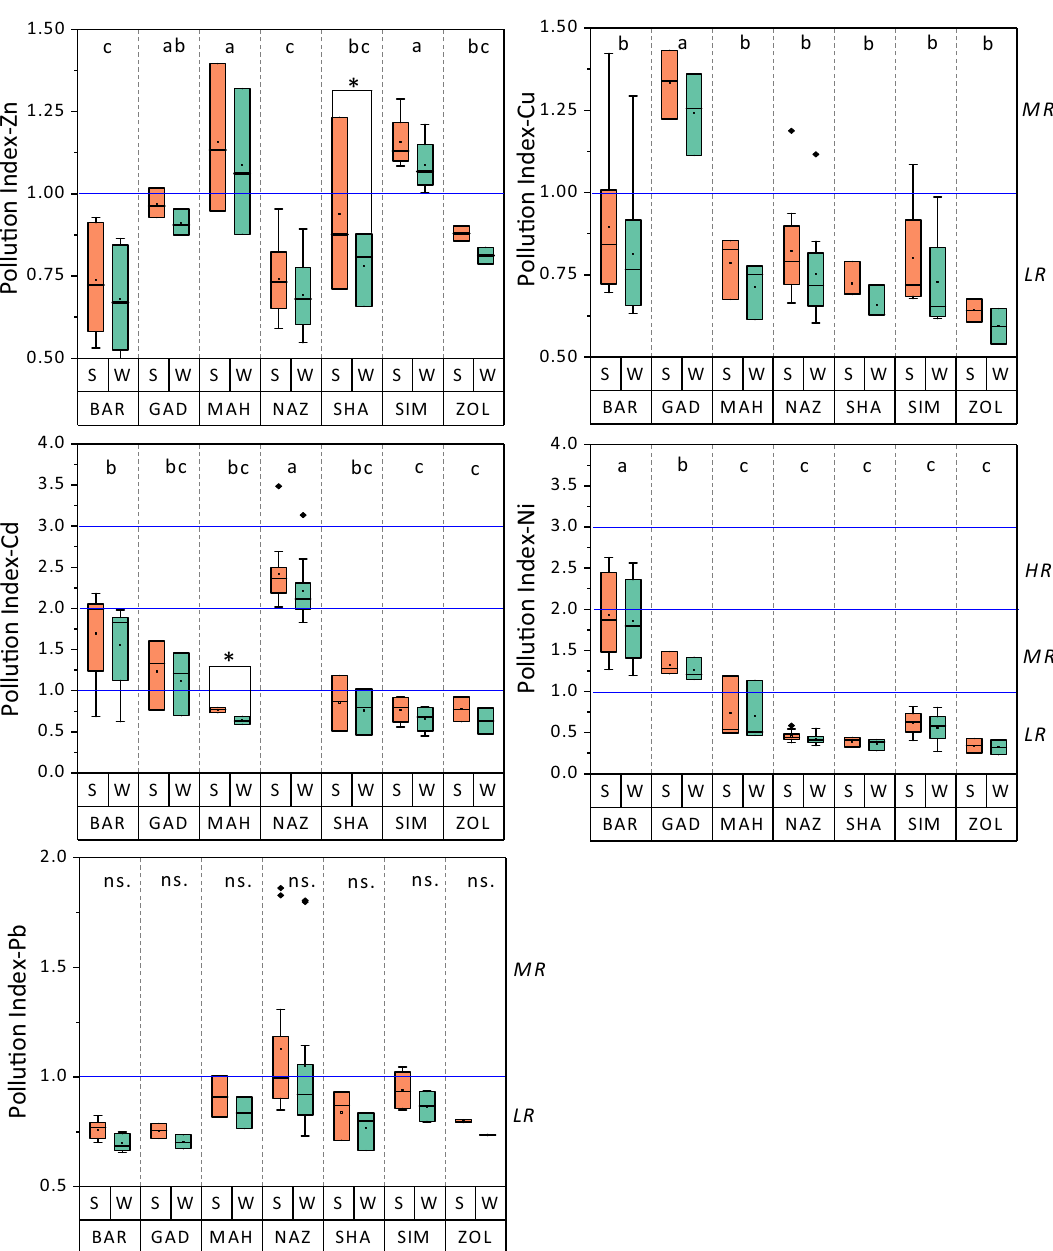
Figure 4. The comparison of the mean pollution index of Zn, Cu, Cd , Pb , and Ni between summer and winter in the study rivers’ sediments. Different letters represent significant differences in enrichment factor among rivers pooled over seasons at P < 0.05 confidence level. * represents significant differences between summer and winter measrements at P < 0.05. Horizontal lines demosnstarte the critical levels. LR is “Low Risk”, MR is “Midium Risk”, and HR is “High Risk”. ns. represents the lack of significat